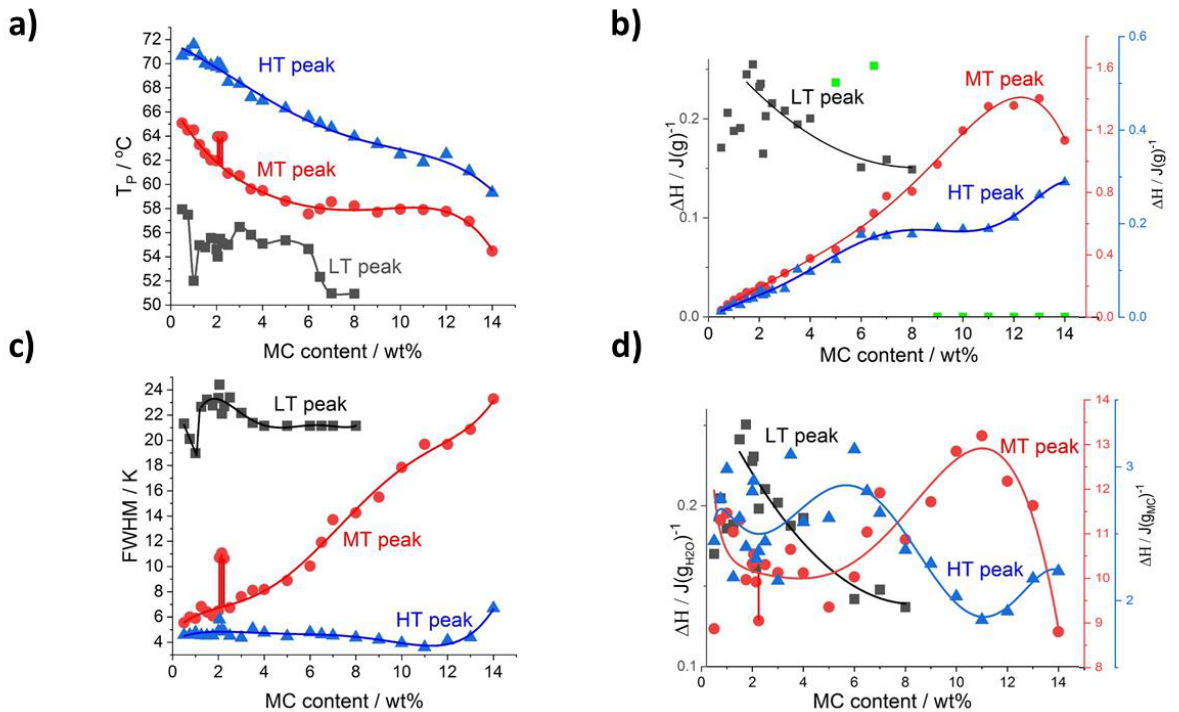
Figure 4. Deconvolution results for heating scans as a function of MC content: ( a ) peaks’ temperature position and ( b ) peak’s transition heat normalized to sample mass ( c ) peaks’ width FWHM, ( d ) peak’s heat normalized to H 2 O (LT peak) and MC content (MT and HT peaks). Green points in ( b ) are LT peak area values excluded from the trend analysis due to high deviation.